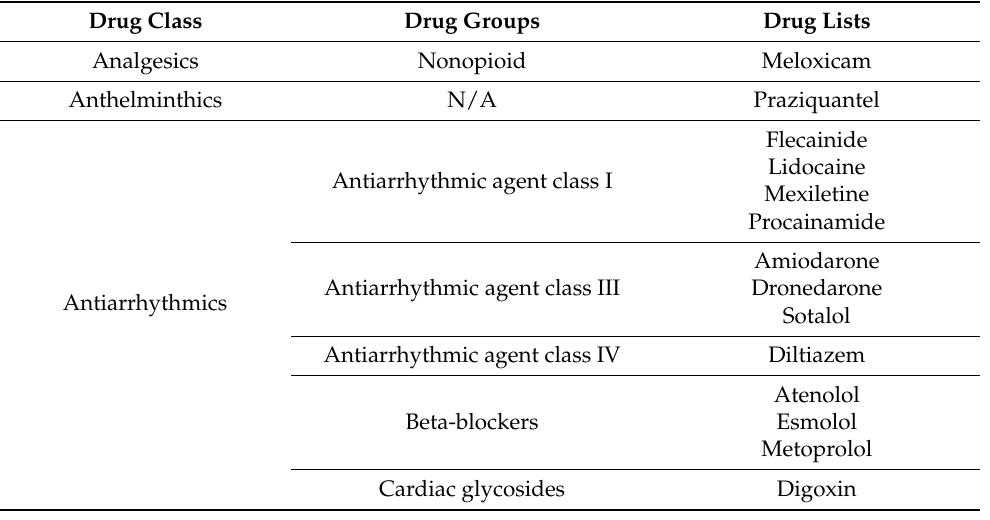
Table 1. List of drugs used for the potential DDI